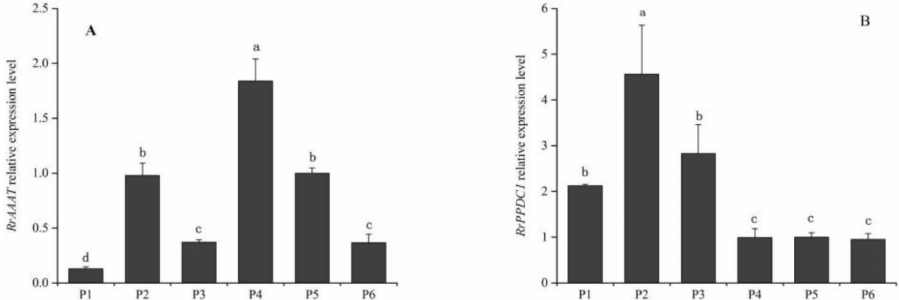
Figure 5. Quantification of gene expression levels in different parts of flower organs of R. rugosa ‘Tanghong’ through real-time PCR. ( A ) Relative expression level of RrAAAT gene; ( B ) relative expression level of RrPPDC1 gene; (P1) petal; (P2) stamen; (P3) pistil; (P4) calyx; (P5) receptacle; (P6)